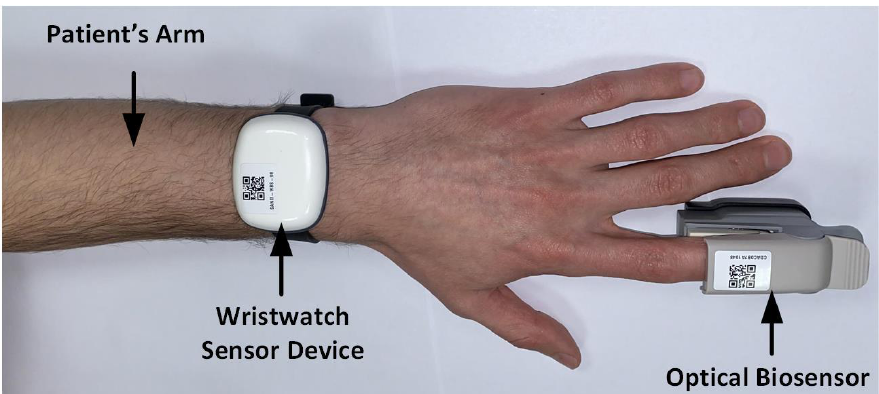
Figure 19. Wristwatch sensor device worn by a patient in a clinical setting.